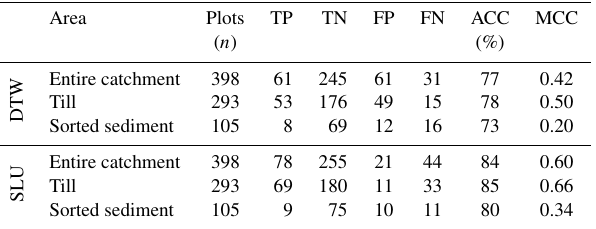
Table 3. Confusion matrix of true positive (TP), true negative (TN), false positive (FP) and false negative (FN) values, representing wet (positive) and dry (negative) plots predicted by DTW 1ha at 1m resolution and the SLU soil moisture map, as well as prediction accuracy (ACC, %) and the Matthews correlation coefficient (MCC, %). Confusion matrixes and statistics were calculated for the entire catchment and divided into till and sorted sediment